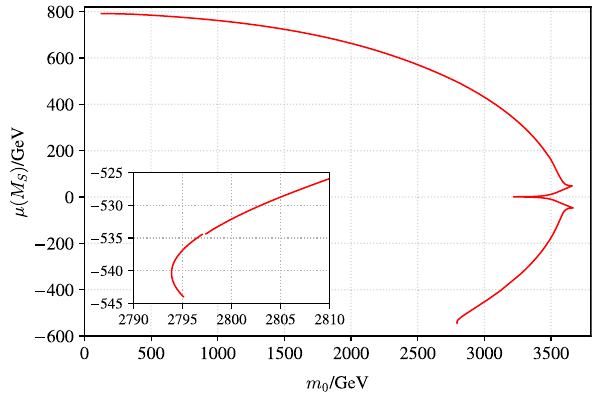
Fig. 8 The SAS results with zoom for the low-scale input parameters { M , G } and the CMSSM parameters from Eq.(9). m Z F imum at μ = − 540 . 5GeV, which gives rise to multiple solutions to the CMSSM BVP